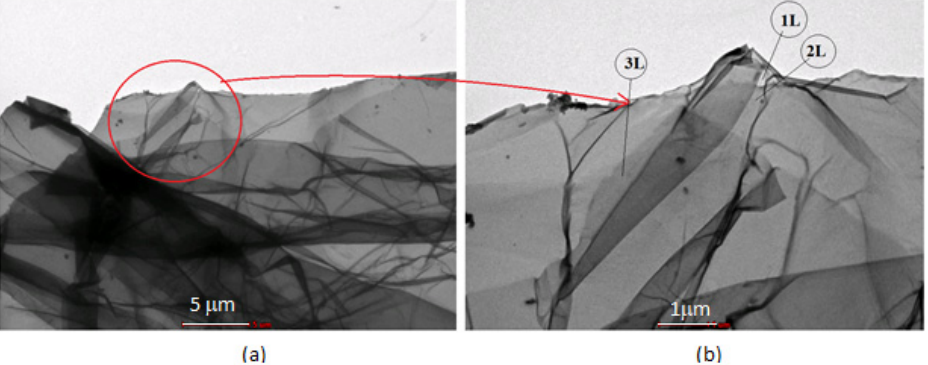
Figure 6. ( a ) TEM image of graphene; ( b ) is the red line marks the highlighted part of image ( a